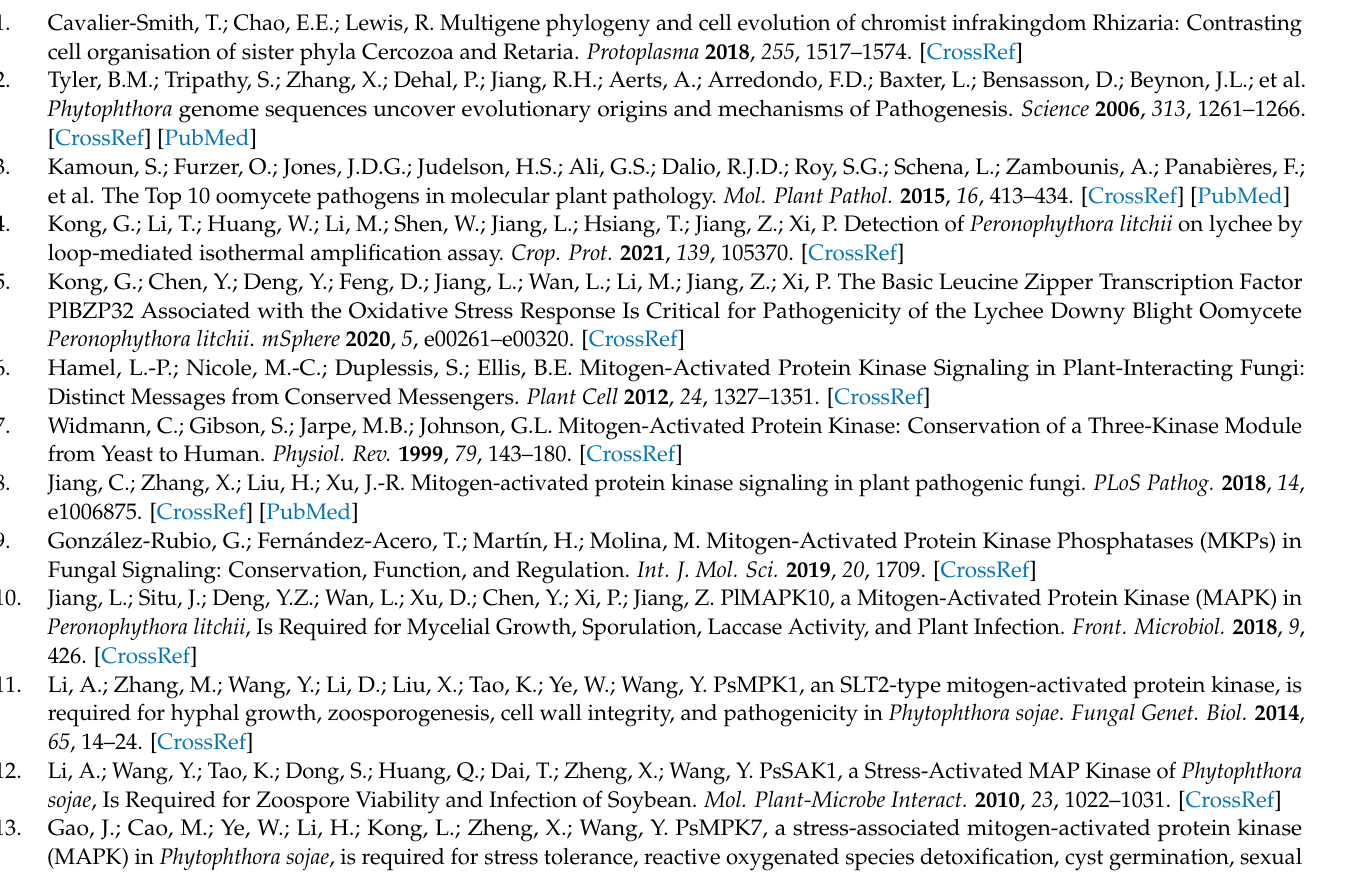
displayed. Figure S2 PlMAPK2 is not associated with growth and responses to various stresses. (A) WT and PlMAPK2 mutants were inoculated on CJA medium, photographs were taken 5 days after inoculation. (B) WT and PlMAPK2 mutants were inoculated on Plich medium with or without indicated chemicals (350 µ g/mL CFW, 25 µ g/mL SDS, 100 µ g/mL CR, 1 mM H 2 O 2 , 2 mM H 2 O 2 , 5 mM H 2 O 2 0.05 mM NaCl, 0.1 mM NaCl, 0.2 mM NaCl, 0.1 mM CaCl 2 and 0.2 mM CaCl 2